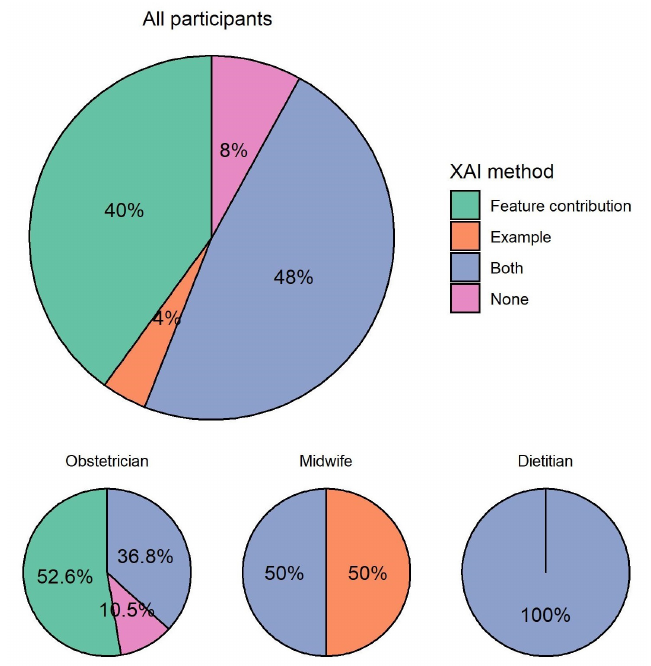
Figure 7. Healthcare practitioners’ preference for explanations in a